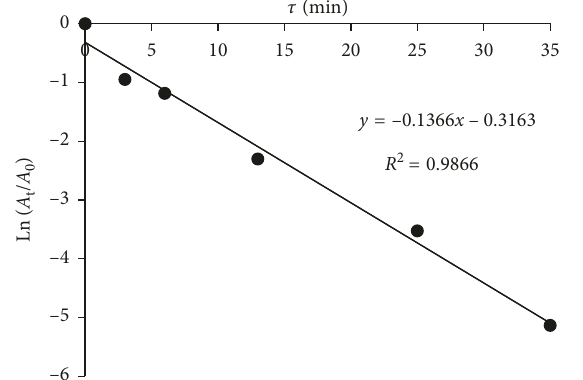
Figure 10: Plot of Ln ( A t / A 0 ) against time for the degradation of methylene blue using 0.05 mL of